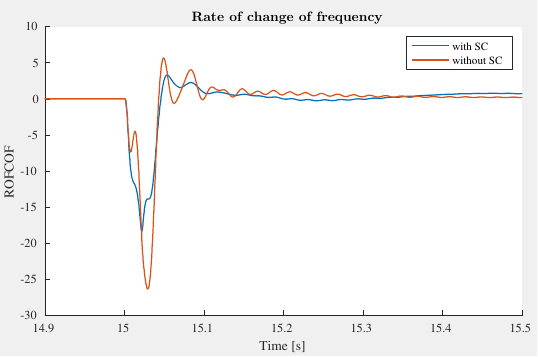
Figure 4. Comparison of the rate of change of frequency.